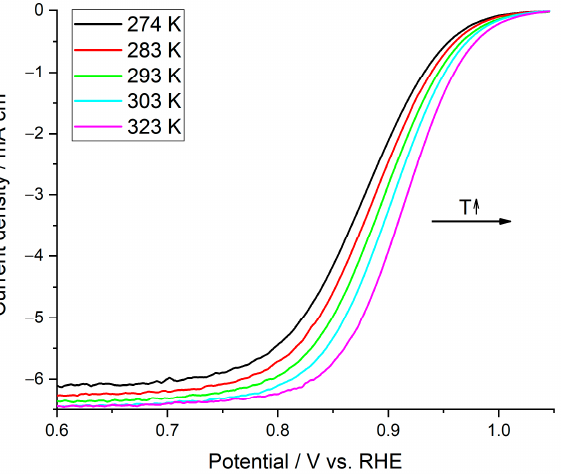
Figure 6. RDE polarization curves (20 mV s − 1 ) for the ORR at a Pt 20 /C-coated disk electrode rotating at 1600 rpm in a 0.1 M HClO 4 solution at different temperatures in the range from 1 to 50 °C.